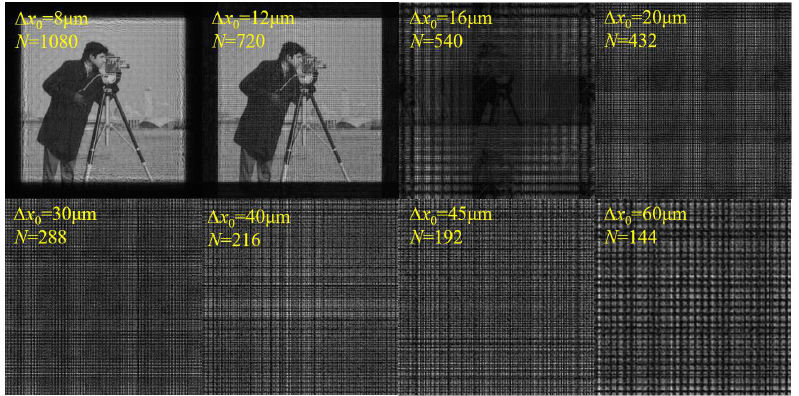
Figure 4. Calculated amplitude distributions on the diffraction plane with different ∆ x 0 and N using SFD.